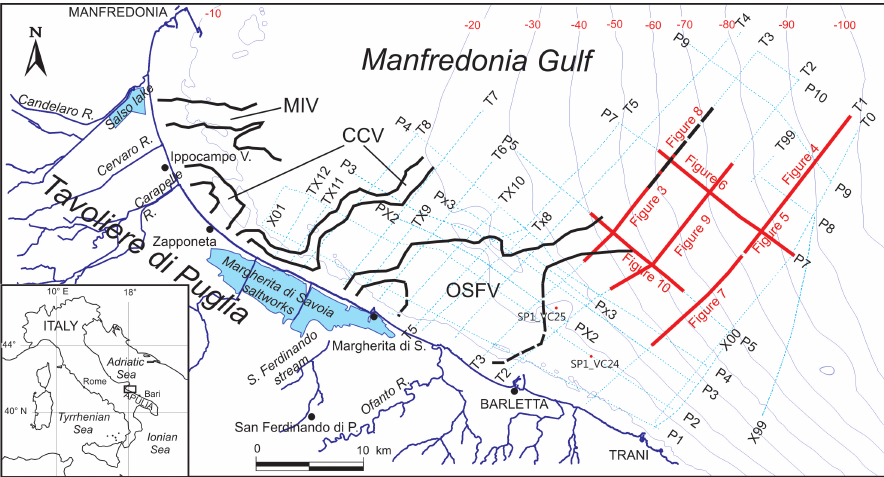
Figure 1. Study area with seismic profiles acquired in the surveys 2016–2017 (cyan); the thick black lines indicates the edges of Manfredonia incised valley (MIV, from [32]), Carapelle and Cervaro valley (CCV, from [27,32]), and Ofanto San Ferdinando valley (OSFV, from [27]). Sea bottom contour lines are also reported. The red or black dashed parts of the seismic profiles correspond to the sections reported in the figures